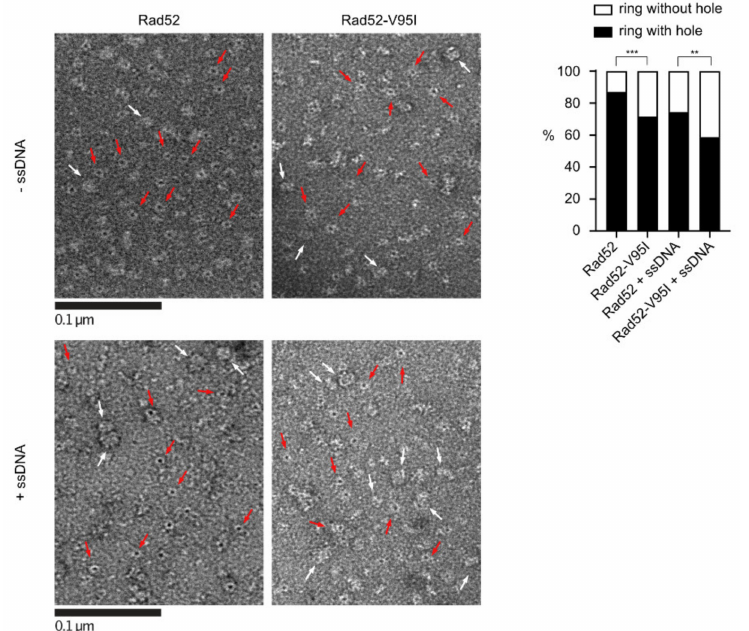
Figure 5. EM analysis of Rad52 and Rad52-V95I without DNA (upper panels) or with 400nt-ssDNA (lower panels). All experiments were performed with FLAG-tagged Rad52 proteins. The protein- ssDNA complex was formed at a ratio of 1:20 nucleotides. Some representative rings with holes (red arrows) and without holes (white arrows) are shown. The percentage of each molecular species is plotted on the histogram (right panel). 641 molecules were analyzed; *** p < 0.001; ** p < 0.05 (two-tailed Fisher’s exact